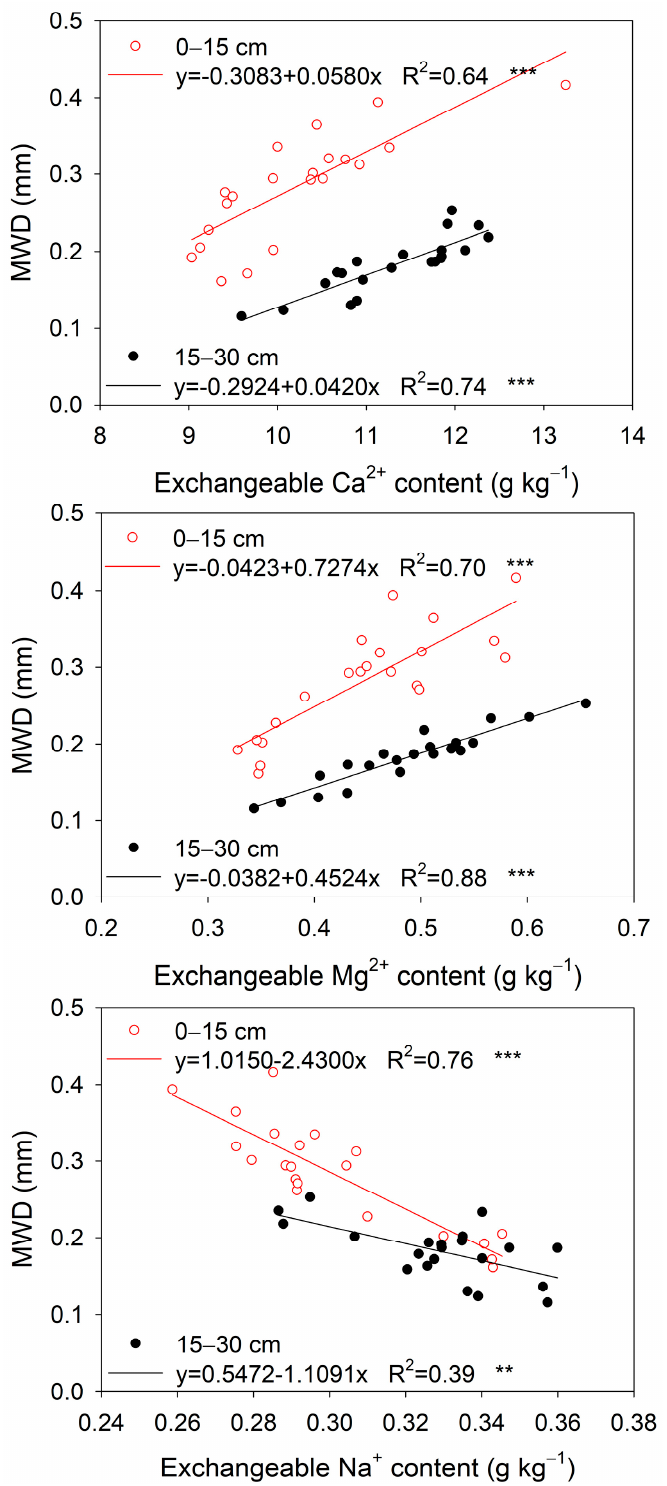
Figure 5. Relationships between mean weight diameter (MWD) and soil exchangeable calcium (Ca 2+ ), magnesium (Mg 2+ ) and sodium (Na + ) contents. Red and black lines indicate relationships between MWD and exchangeable cations at 0–15 and 15–30 cm depths, respectively. ** p < 0.01, *** p < 0.001.